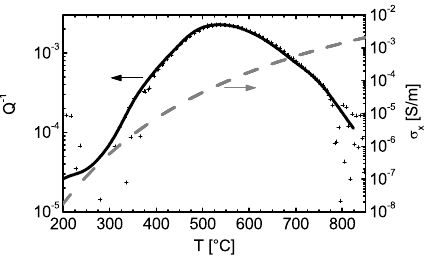
Figure 5. Conductivity of LGS as function of temperature.